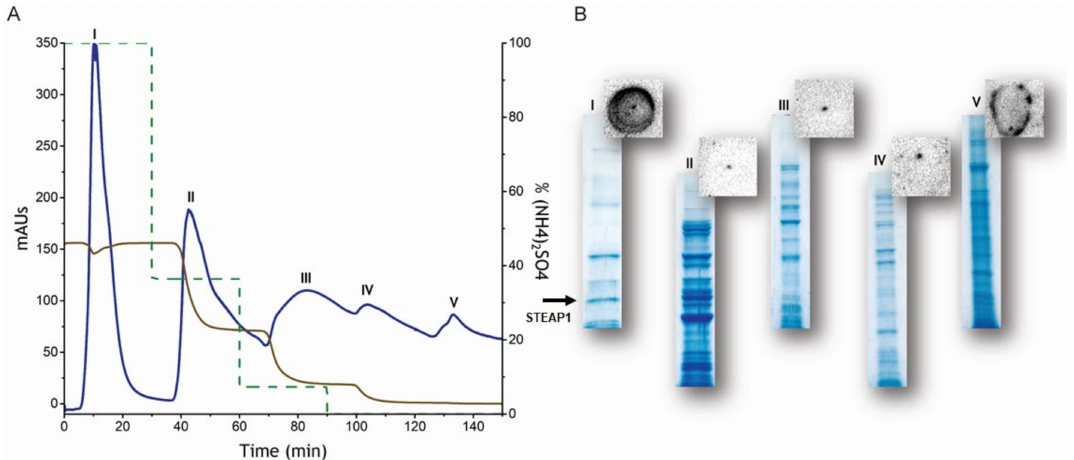
Figure 1. ( A ) Chromatographic profile of STEAP1 purification on Butyl-Sepharose 4 FF resin with optimized conditions. Blue line represents absorbance at 280 nm. Adsorption performed at 1.375 M (NH 4 ) 2 SO 4 in 10 mM Tris-HCl buffer at pH 7.8 (1.0 mL min − 1 ). Desorption was performed at 500 mM and 100 mM (NH 4 ) 2 SO 4 , 10 mM Tris-HCl and a final step with H 2 O (1.0 mL min − 1 ), in stepwise gradient. ( B ) SDS-PAGE and dot-blot analysis depicted for each peak. The gel was stained with Coomasie brilliant blue and the membranes were incubated with anti-STEAP1 mouse primary antibody overnight at 4 ◦ C, followed by goat anti-mouse secondary antibody incubation at room temperature. STEAP1 is marked with a black